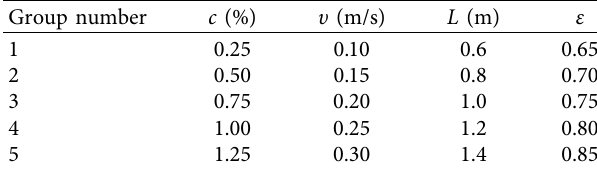
Table 1: Influencing factors and levels of the orthogonal test.